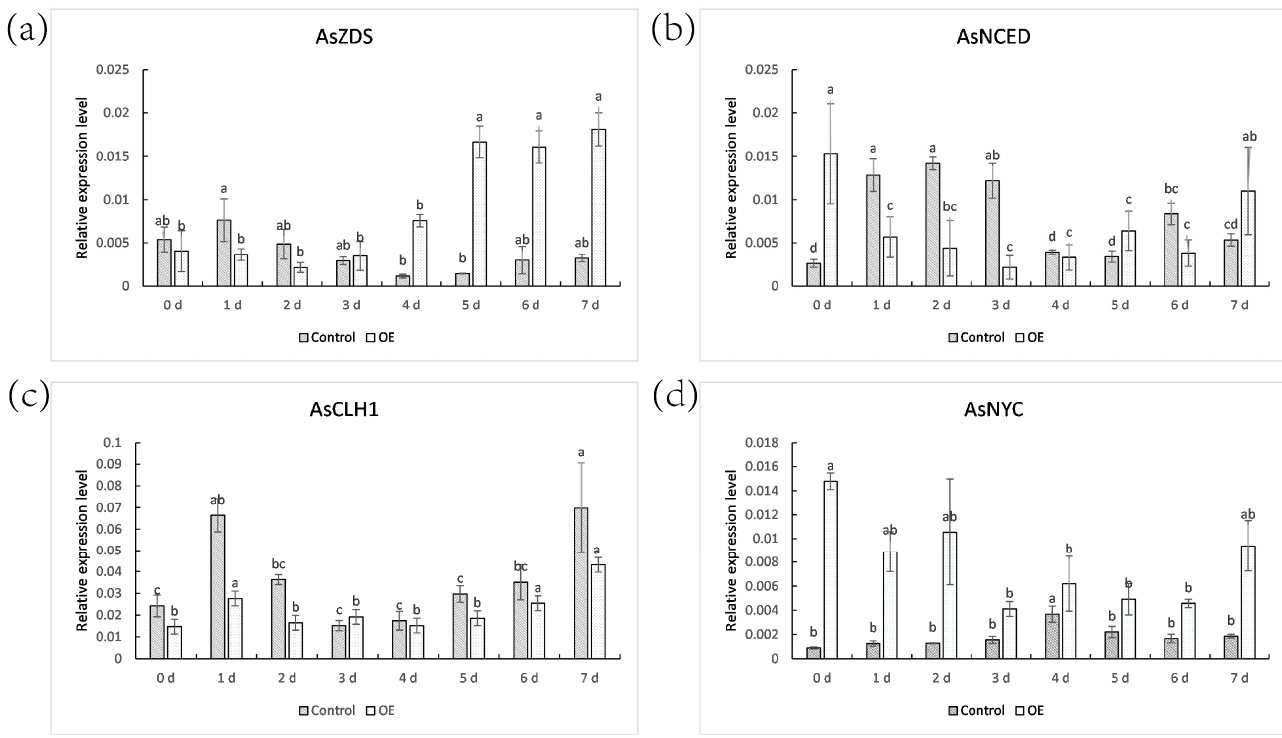
Figure 4. Expression levels of AsZDS ( a ), AsNCED ( b ), AsCLH1 ( c ), AsNYC ( d ) in control and OE subjected to dark at 0–7 days. The control (grey) and OE (white) columns were separately compared using one-way ANOVA with Duncan test. Significant differences ( p < 0.05, n = 3) are shown by different letters above the columns.